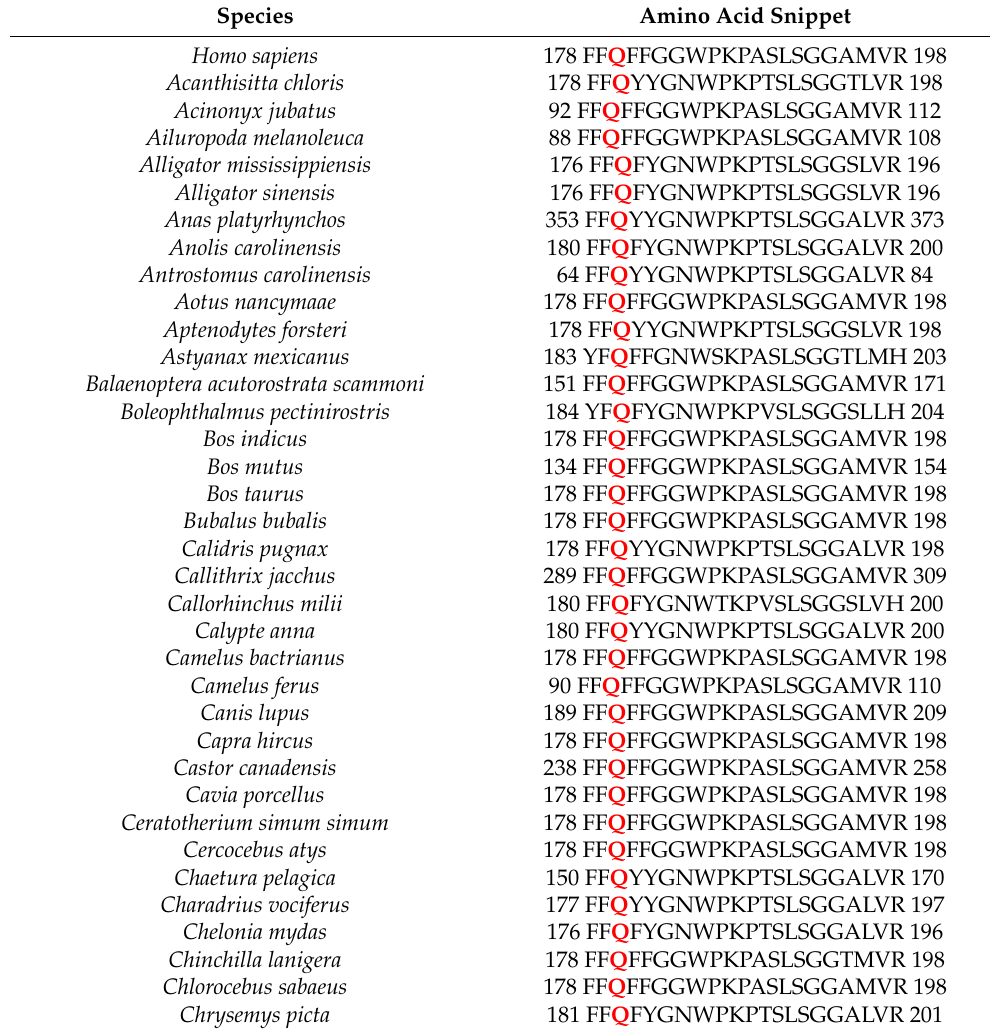
Table A2. Sequence conservation of the p.(Q180E) variant in orthologous C1QTNF5 protein se-